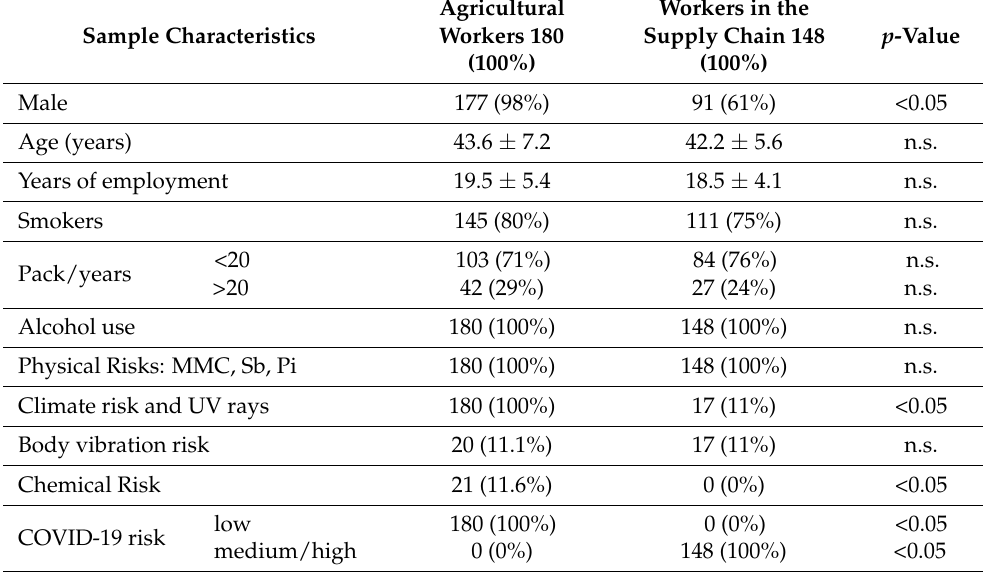
Table 2. Main sample